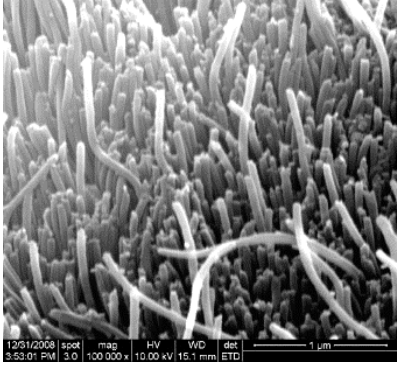
Figure 5. SEM image of the PPy nanowires grown in the AAO template. Reproduced from [21]. Copyright (2017), with permission from Elsevier.